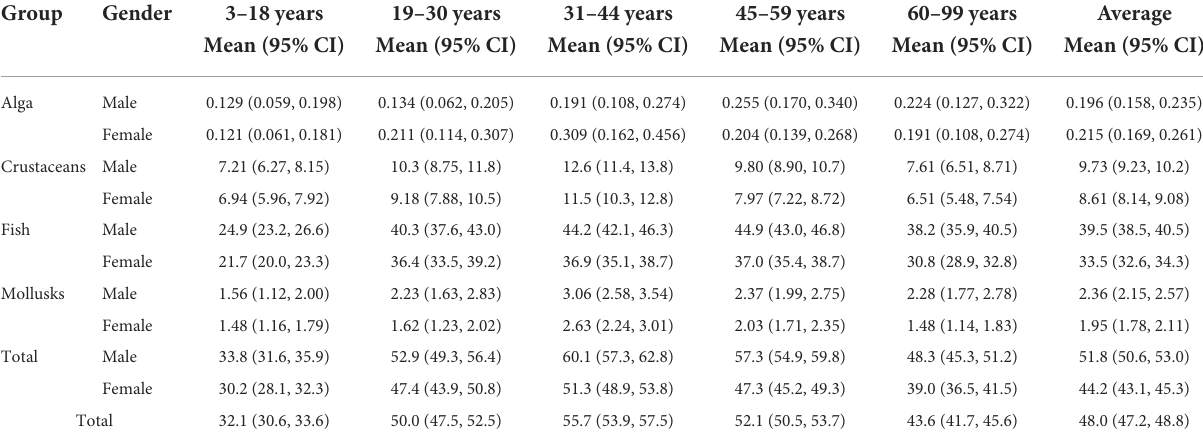
TABLE 2 Daily aquatic products consumption by gender and age groups using 24h recalls (g/d) ( n = 24,106) * .